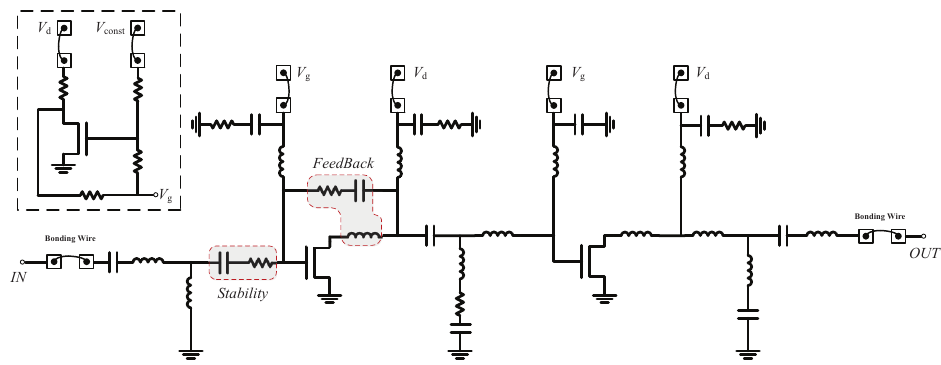
Figure 8. Complete schematic diagram of the designed broadband driver amplifier.